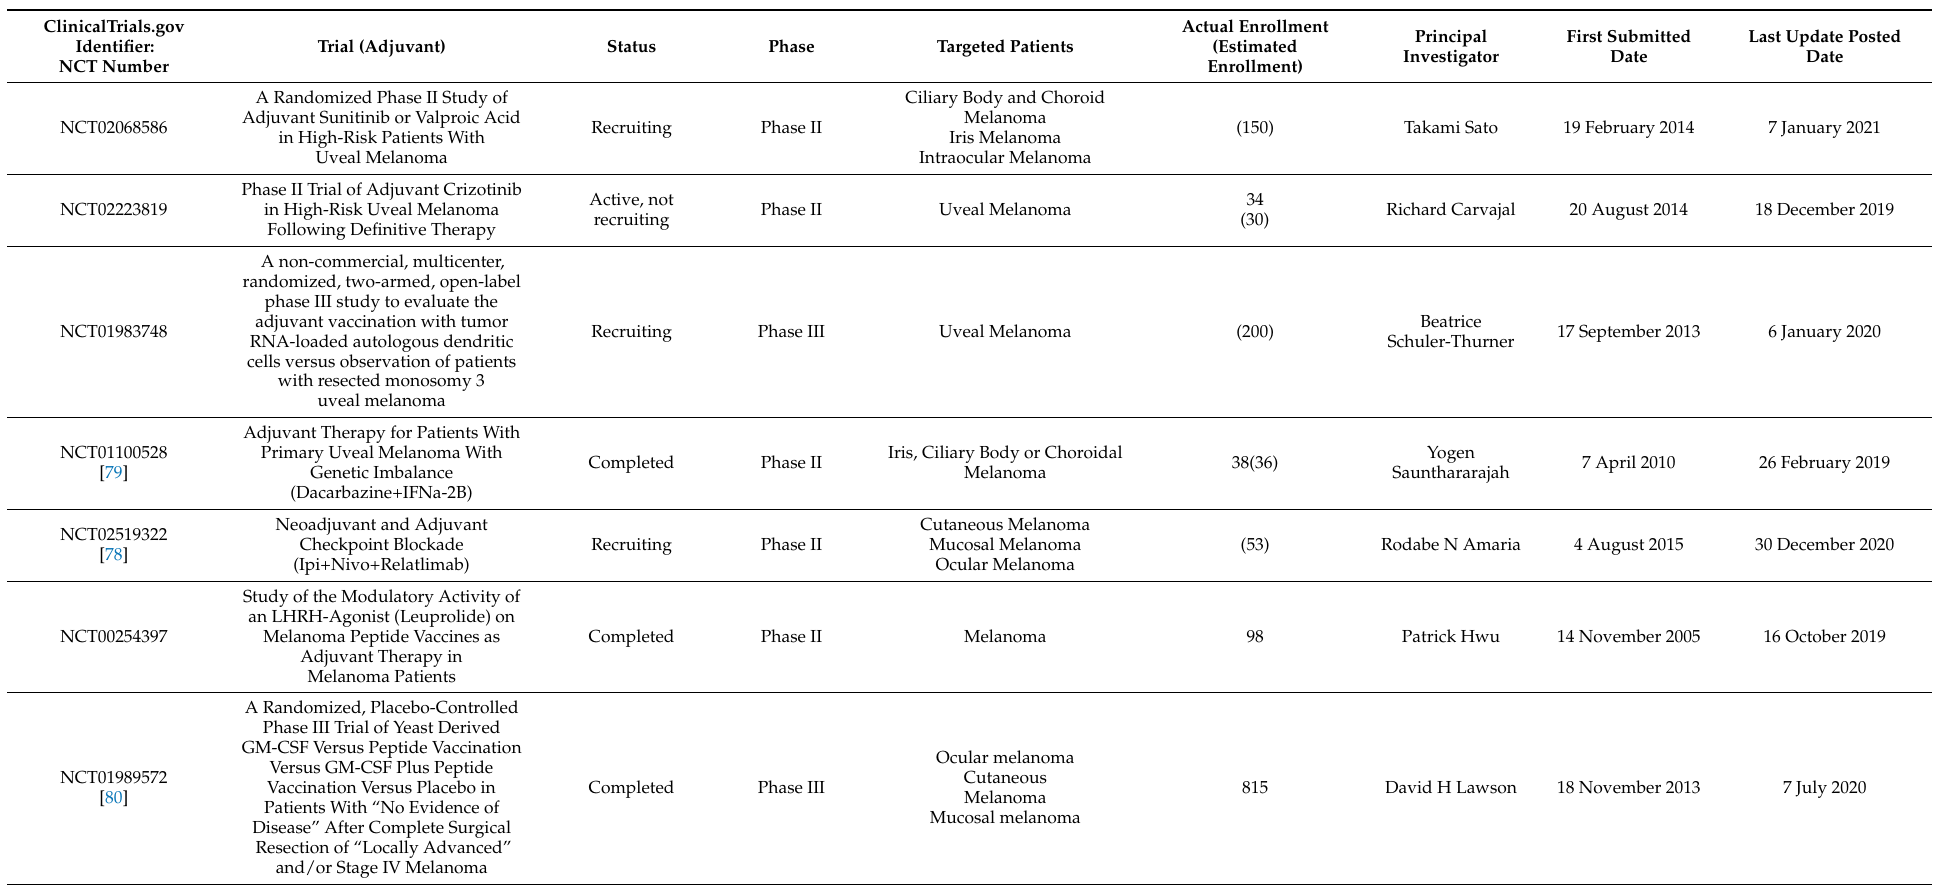
Table 2. Ongoing clinical trials with adjuvant and not adjuvant therapies in